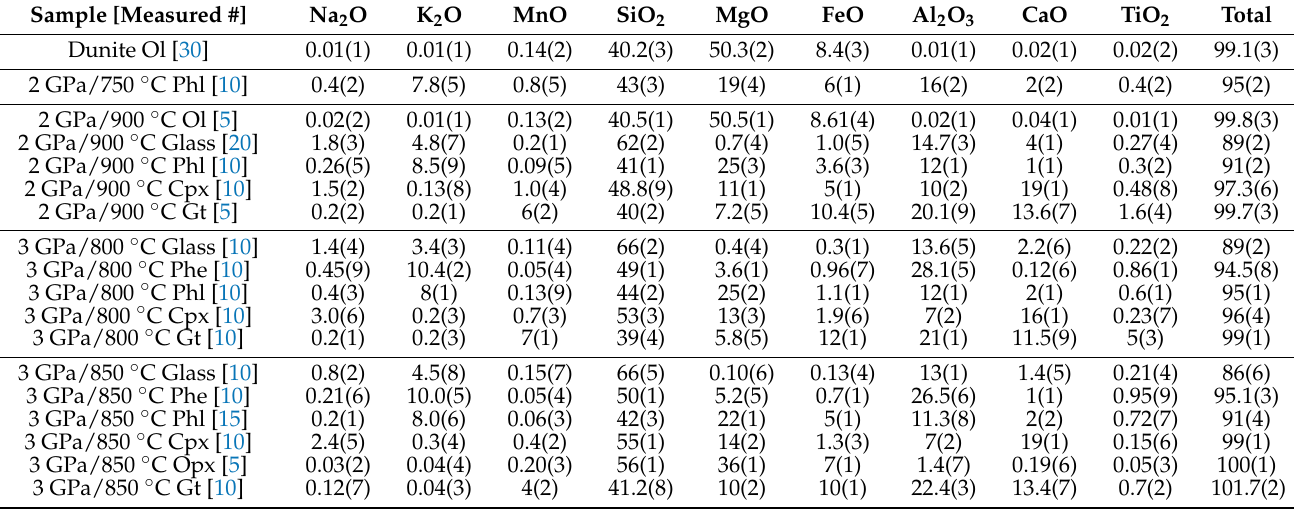
Table 2. Average compositions of analyzed phases for each